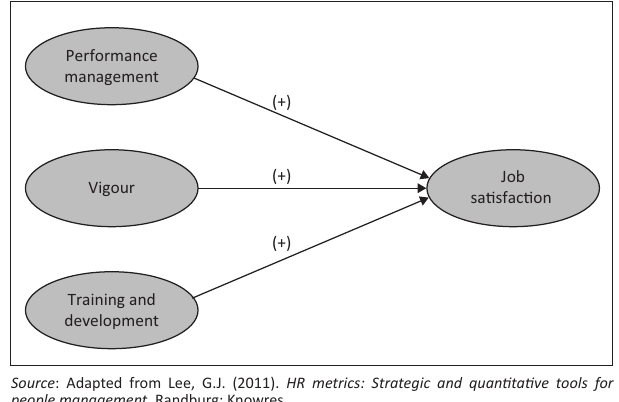
FIGURE 1: Performance management, vigour, and training and